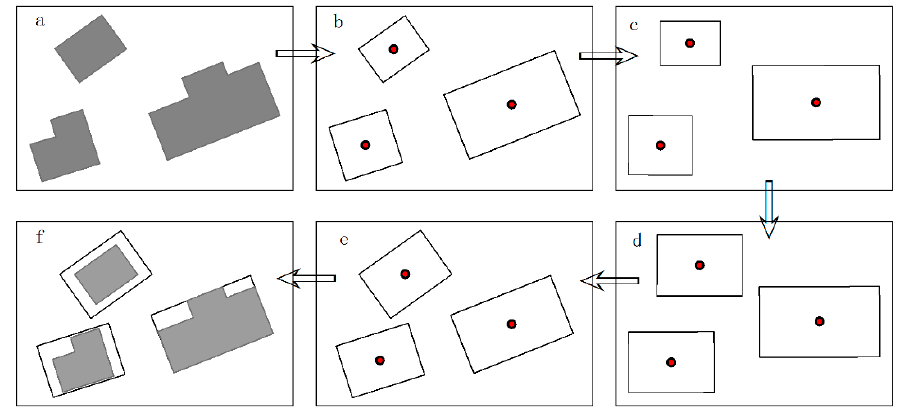
Figure 13. Building enlargement process: ( a ) original buildings; ( b ) SMBRs; ( c ) first rotation; ( d ) simple geometric transformation; ( e ) second rotation; ( f ) buildings after enlargement compared to their initial states.